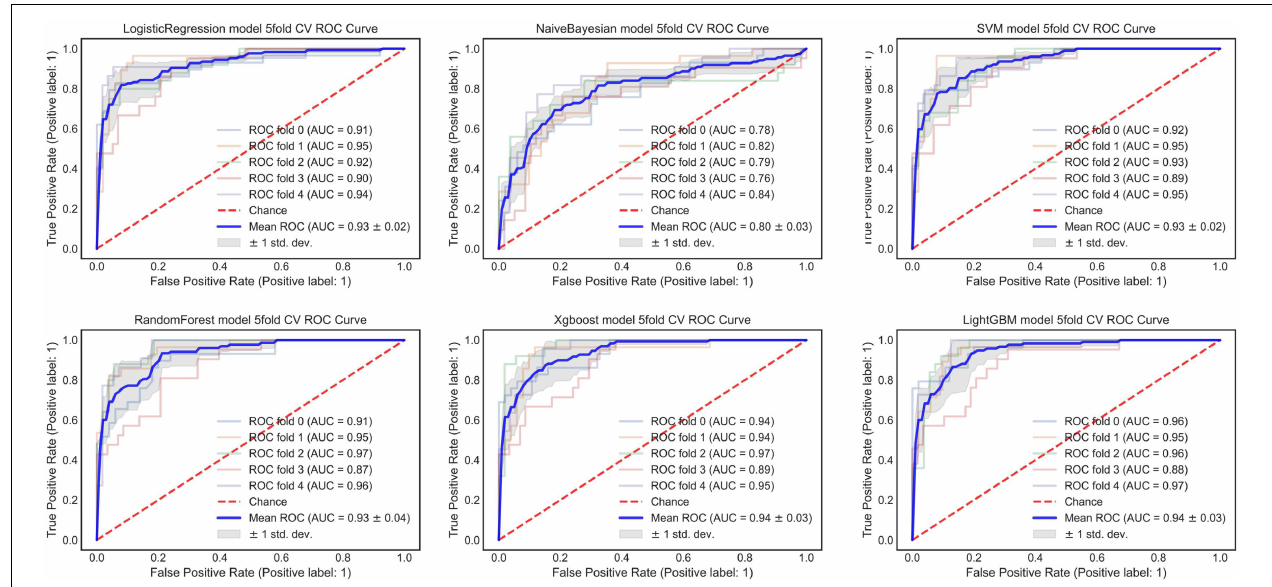
FIGURE 7 | The AUC of the radiomic model for predicting EVAR-related SAEs in the training set. AUC, area under the curve; SAEs, severe adverse events; EVAR, endovascular aneurysm